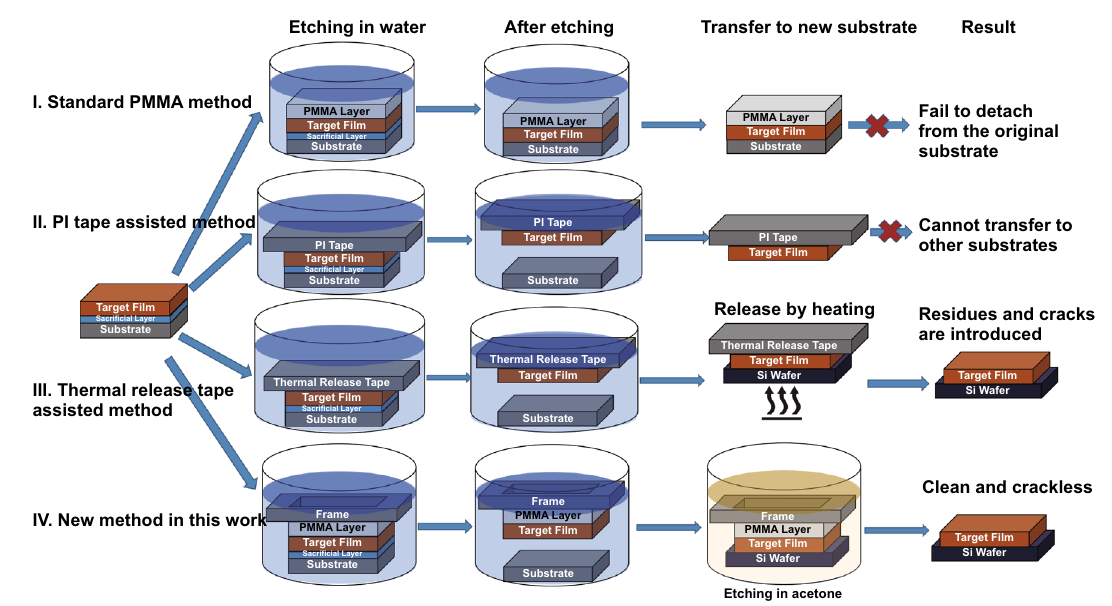
Fig. 1 Schematics of four different wet‑etching‑based methods to fabricate oxide thin films. Methods I‑III are known methods, and method IV is the new method developed in this